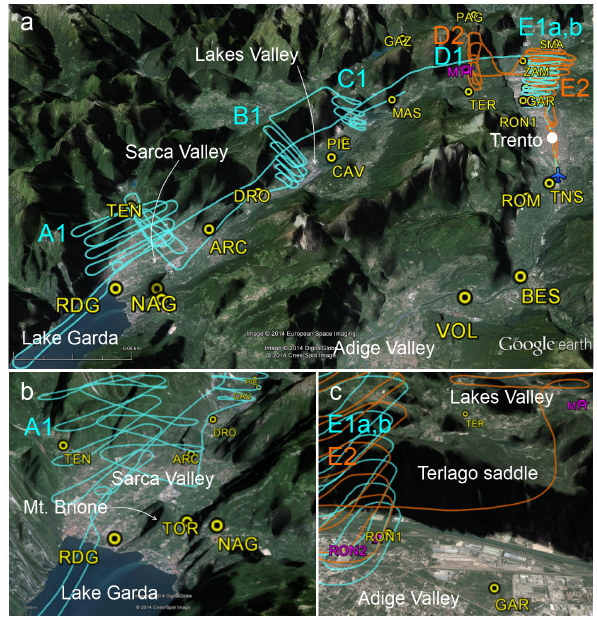
Figure 2. (a) Representation of the flight trajectories (cyan line: flight 1; orange line: flight 2). The names of the single spirals (i.e. sites) are indicated in corresponding colours (see Table 1; no- tice that spirals D1 and E1b, which lack the GPS data, are also in- dicated at the corresponding sites). Routinely operated AWSs and intensive surface measurement sites are shown respectively by yel- low and magenta place marks (see Table 2). View is from SE. (b) Close-up of the shoreline area and the Sarca Valley (view is from S). (c) Close-up of the area of the Terlago saddle, north of Trento (view is from E). Background images: © 2014 Google Earth, © 2014 Eu- ropean Space Imaging, © 2014 DigitalGlobe, © 2014 CNES–SPOT